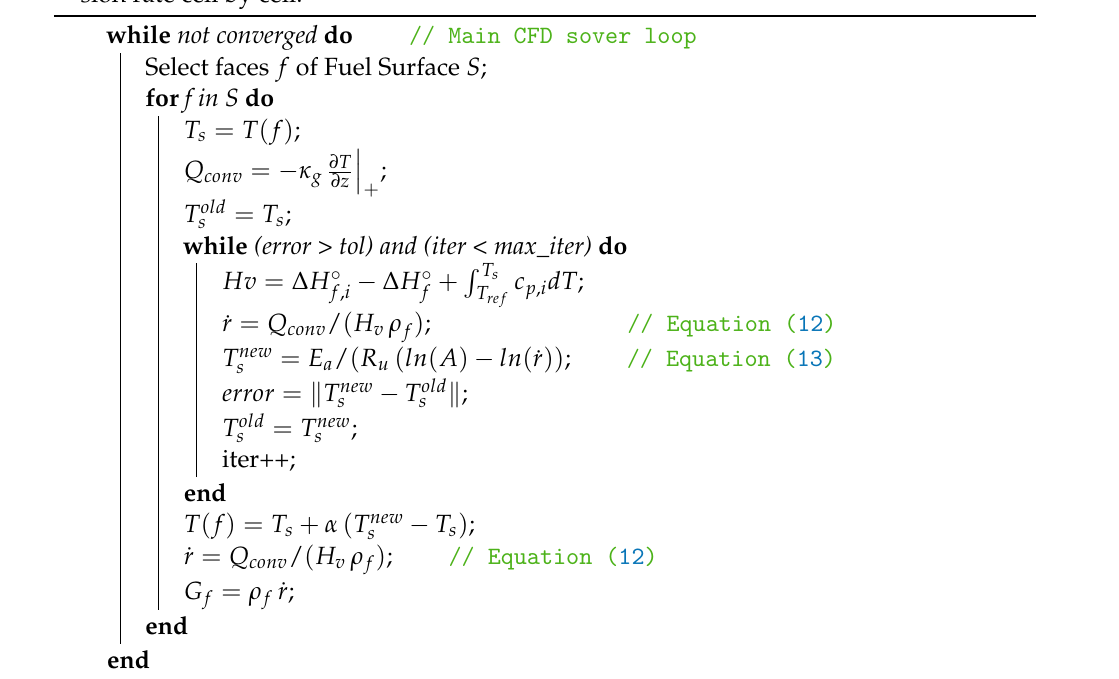
Algorithm 1: Pseudo-code version of UDF’s main operations to calculate regres- sion rate cell by